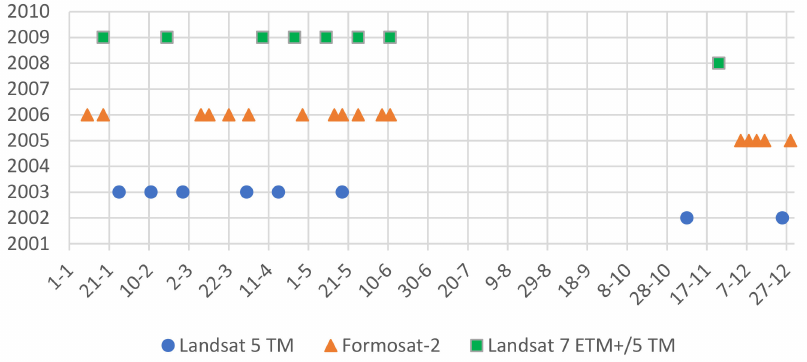
Figure 2. Acquisition dates for the satellite images during the three growing seasons.